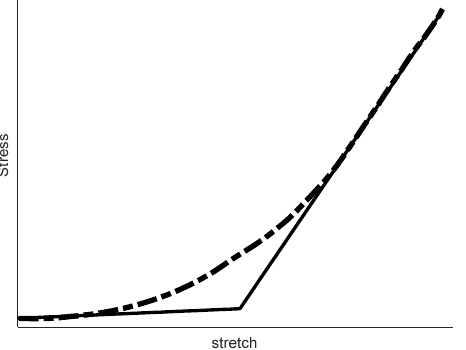
Figure 1. A typical stress-stretch curve of the arterial tissue samples is shown. The dashed line represents the: typical stress-stretch curve and the solid lines the initial and final curve tangents. The starting slope of the curve, E init , provides the stiffness of the ECM in crimped state of many collagen fibers). The tangent line of the linear region (in higher stretches), named E fin , demonstrates ECM stiffness with mechanical load-bearing of most of the collagen fibers. These two elasticity moduli were computed for the range of biaxial test data from the control and hypertensive groups.